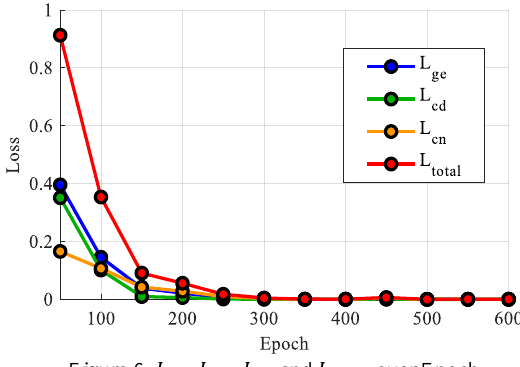
Figure 6. 𝐿 𝑔𝑒 , 𝐿 𝑐𝑑 , 𝐿 𝑐𝑛 and 𝐿 𝑡𝑜𝑡𝑎𝑙 over Epoch